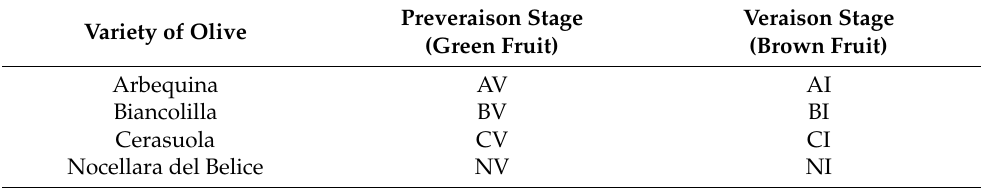
Table 1. List of the varieties of olive in two diverse stages with relative initials. Preveraison Stage Veraison Stage Variety of Olive (Green Fruit) (Brown Fruit) Arbequina AV AI BV